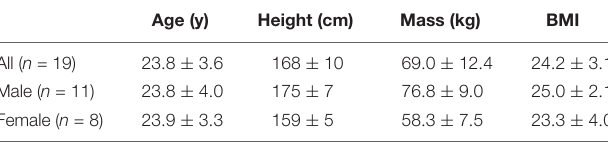
TABLE 1 | Morphometrics of the subject